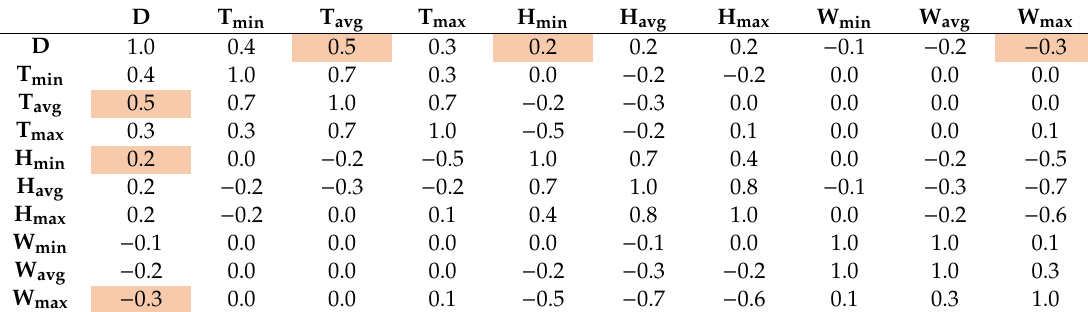
Table 2. Energy demand correlation matrix vs. meteorological data–Market